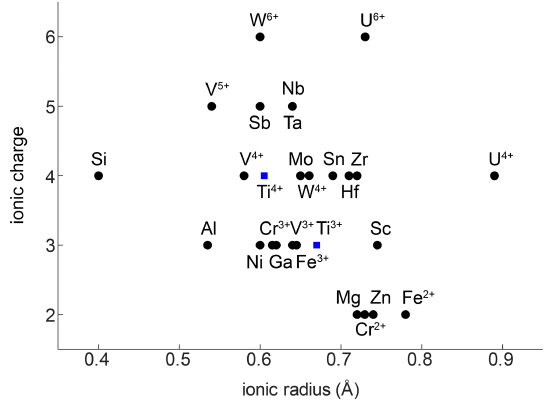
Figure 1. Ionic radius vs. ionic charge of minor and trace elements that can be substituted into natural rutile. Ionic radii are taken from Shannon